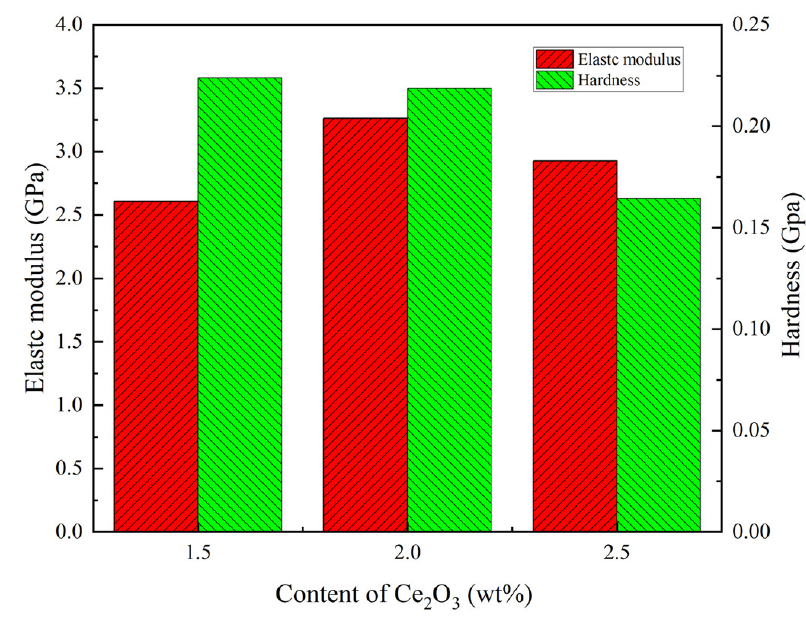
Figure 5. Hardness and elastic modulus of coating.